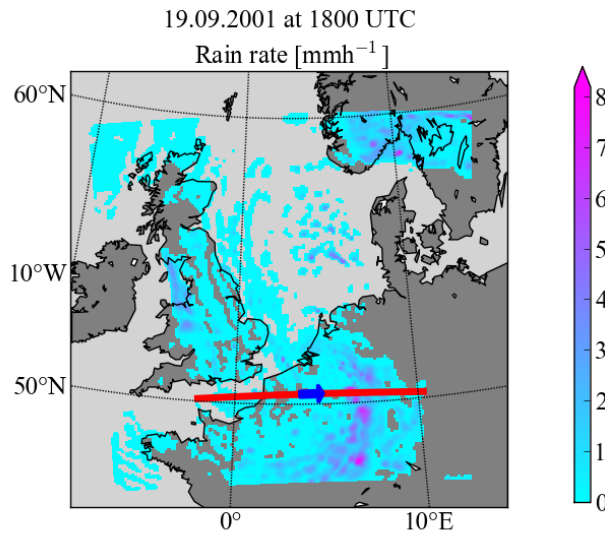
Figure 4. Simulated rain rates in mmh − 1 for the Hoek van Holland case on 19 September 2001 at 18:00UTC. The red line and blue arrow indicate the artificial flight path shown in Figs. 5 and 6.